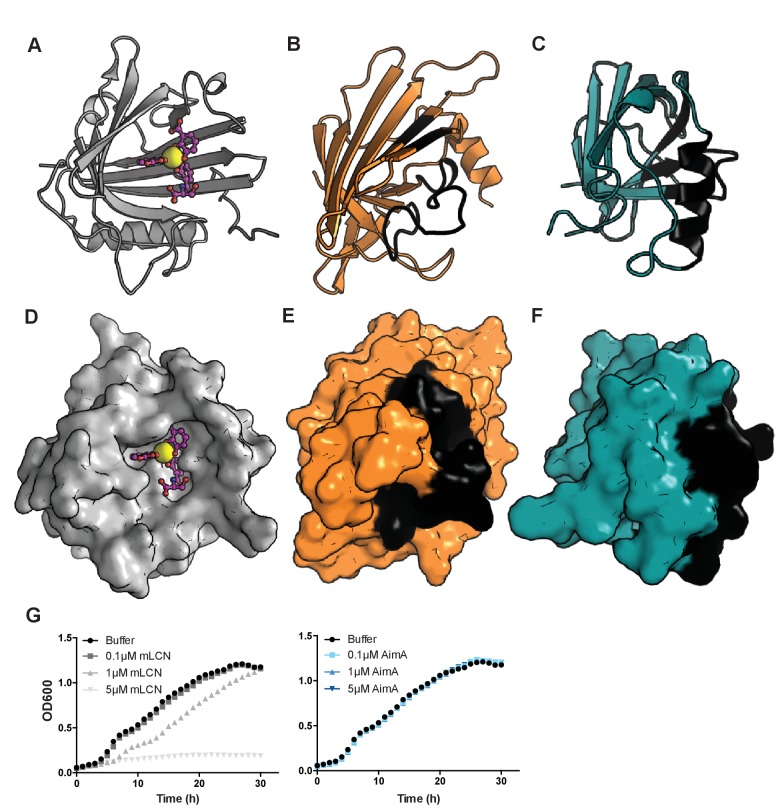
AimA does not bind enterobactin.(A) Shown is a ribbon diagram of the structure of human LCN2 (PDB ID 1L6M) with ferric enterobactin bound. Enterobactin is shown in pink with oxygen in red, nitrogen in blue, and iron as a yellow ball. (B) After overlay with LCN2 from panel A, shown is a ribbon diagram of the structure of AimA N-term domain in the same orientation. The regions colored black indicate residues that would occlude enterobactin binding. (C) After overlay with LCN2 from panel A, shown is a ribbon diagram of the structure of AimA C-term domain in the same orientation. The regions colored black indicate residues that would occlude enterobactin binding. (D–F) Shown are the surface representations of LCN2, N-term AimA and C-term AimA from panels A-C, respectively. Note the deep calyx formed by LNC2 for enterobactin binding is missing in both the N-term and C-term AimA domains. (G) E. coli K12 grown in the presence of the iron chelator dipyridyl experiences a dose dependent growth inhibition upon addition of purified mouse LCN2 protein (left), but does not experience growth inhibition upon addition of the same range of purified AimA concentrations to the E. coli cultures (right).10.7554/eLife.37172.015Figure 3—figure supplement 1—source data 1.AimA does not bind enterobactin.